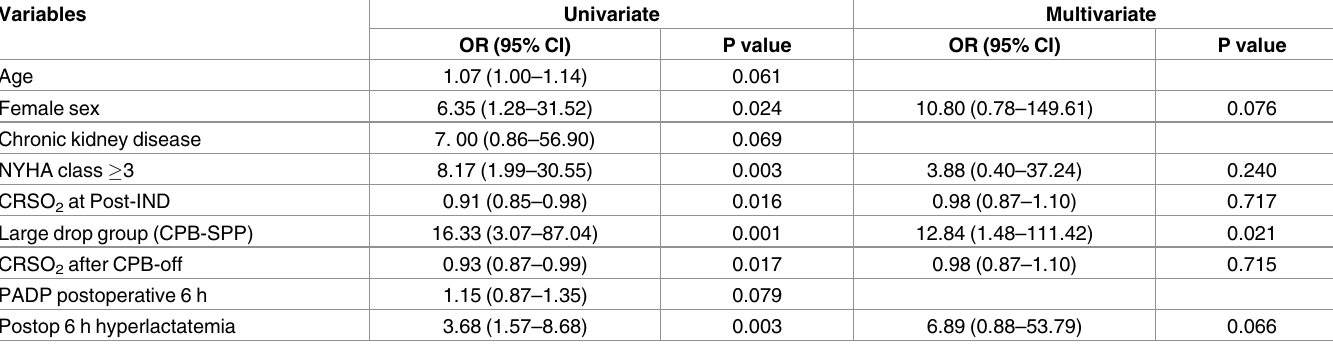
Table 4. Predictive power of selectivevariables for composite endpoint of 30-day morbidity according to logistic regression analysis.